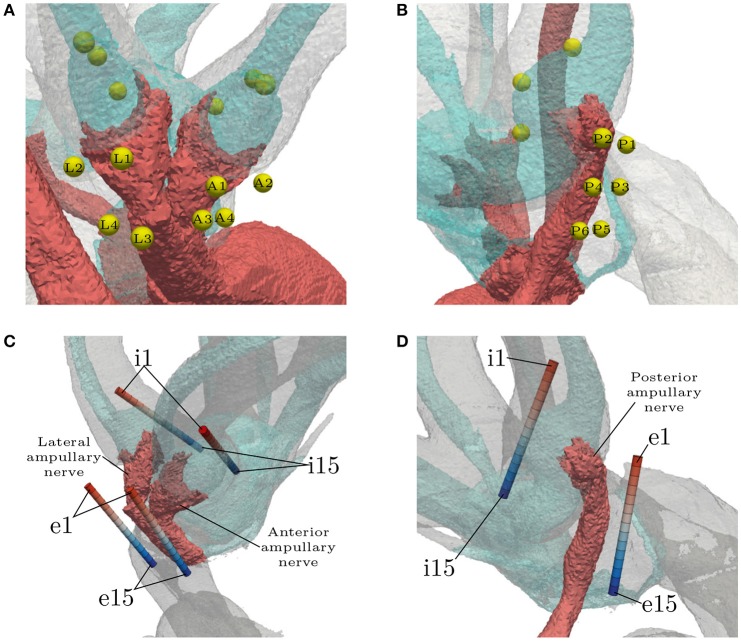
Locations of all spherical (A,B) and cylindrical (C,D) electrode configurations. The light blue structure shows the endolymphatic duct. EL, spherical configuration labels are abbreviated with respect to their target ampullary nerve (Anterior, Lateral, Posterior). IL, spherical electrodes are unlabeled. EL and IL, cylindrical electrodes (denoted by the prefixes e and i, respectively) are numbered in ascending order with respect to the insertion depth. The topmost electrodes are labeled with e1/i1 and the deepest with e15/i15. Optimal placement was assumed to be around the center of the arrays (e8/i8).